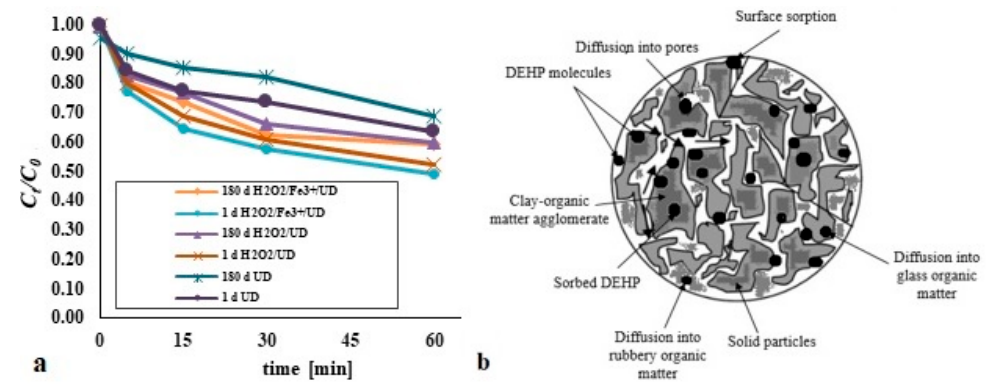
Figure 9. ( a ) The impact of aging contaminants on the efficiency of DEHP removal; ( b ) aging process of pollutants. Parameters: UD ( A = 30%, pH = 10), H 2 O 2 /UD ( A = 30%, DEHP:H 2 O 2 1:1, pH = 10), H 2 O 2 /Fe 2+ /UD ( A = 30%, DEHP:H 2 O 2 :Fe 2+ 1:1:1, pH = 10), H 2 O 2 /Fe 3+ /UD ( A = 30%, DEHP:H 2 O 2 :Fe 3+ 1:1:1, pH = 10).